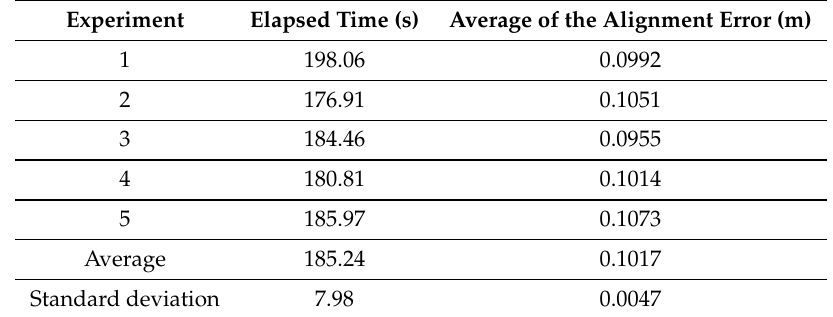
Table 6. Shared Mode